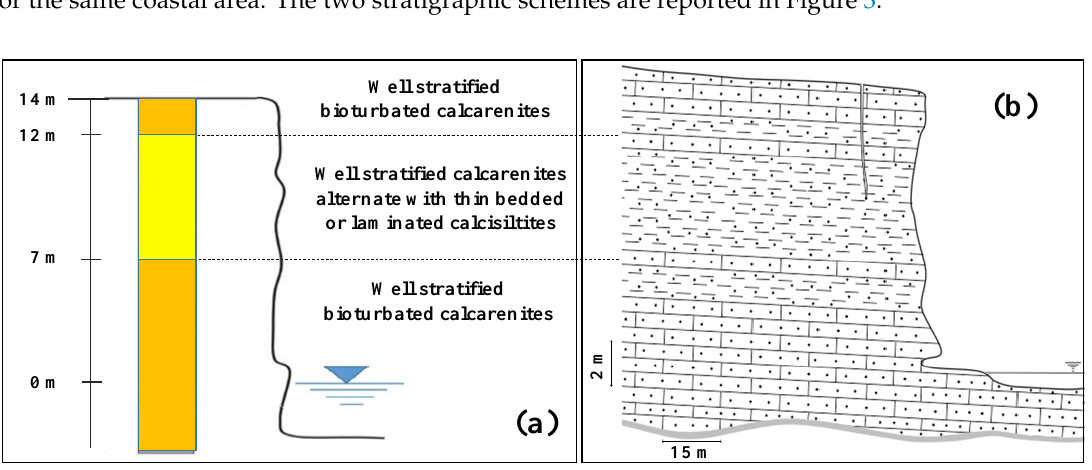
Figure 2. Typical calcarenitic outcrops of sea cliffs, with location (Google Earth ® ), in the marine area of Melendugno: ( a ) North area of Torre dell’Orso; ( b ) Southern area of Sant’Andrea; ( c ) Southern area of Torre dell’Orso; ( d ) North area of Sant’Andrea.